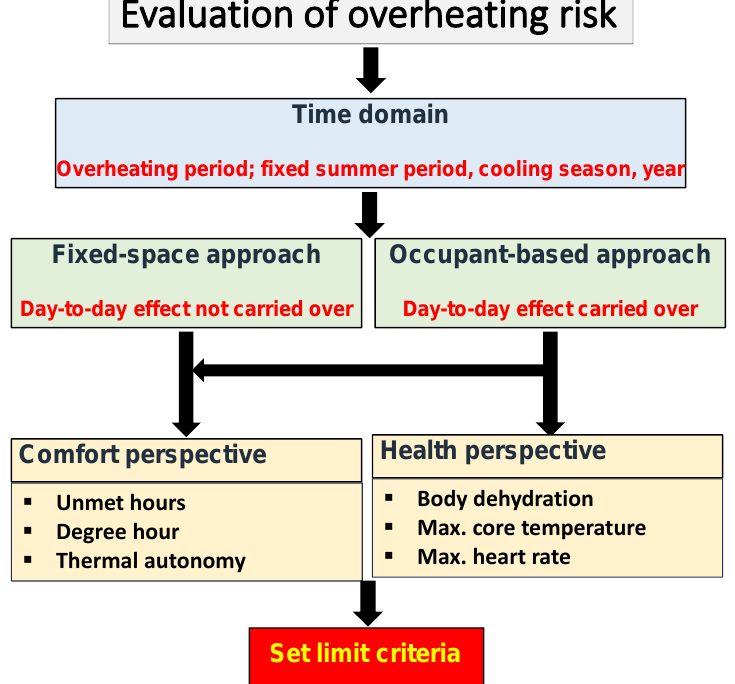
Figure 7. General procedure for overheating risk evaluation.